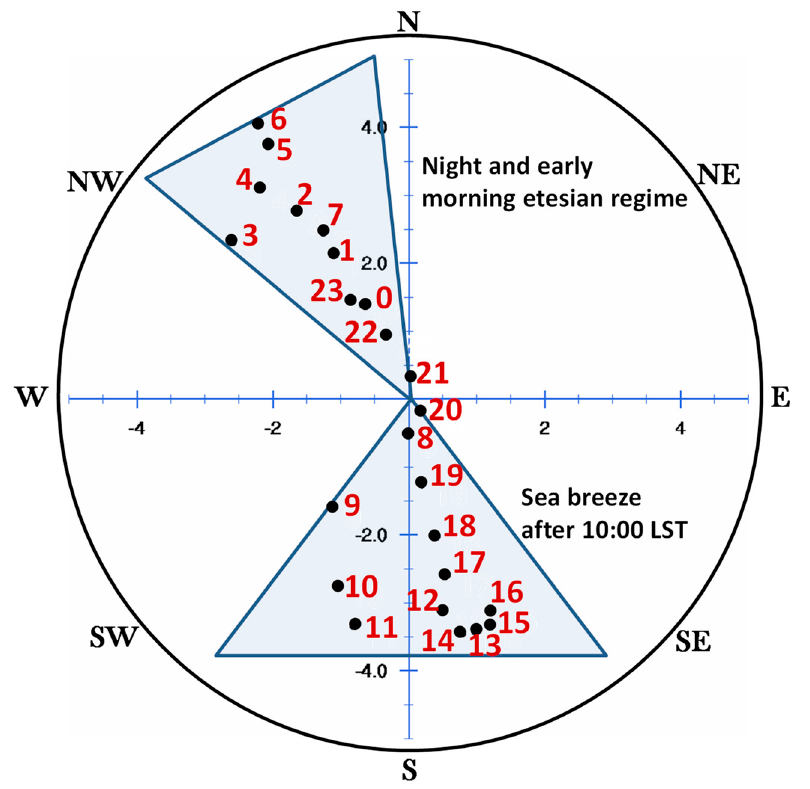
Figure 8. Modeled diurnal variation of the wind inside the battlefield (37.95° N, 23.57° E) from the WRF inner grid (1 × 1 km). Average from the modeling simulations driven by the ERA5 monthly fields for September 2007–2016. Red numbers correspond to local standard time (LST) and the position of the black dots shows the wind speed and direction (e.g., at 06:00 LST the direction is NNW and the speed is computed from u and v wind components as: (cid:3493)(cid:4666)(cid:3398)2(cid:4667) (cid:2870) (cid:3397) 4 (cid:2870) (cid:3406) 4.5 𝑚 𝑠 (cid:2879)(cid:2869) ).